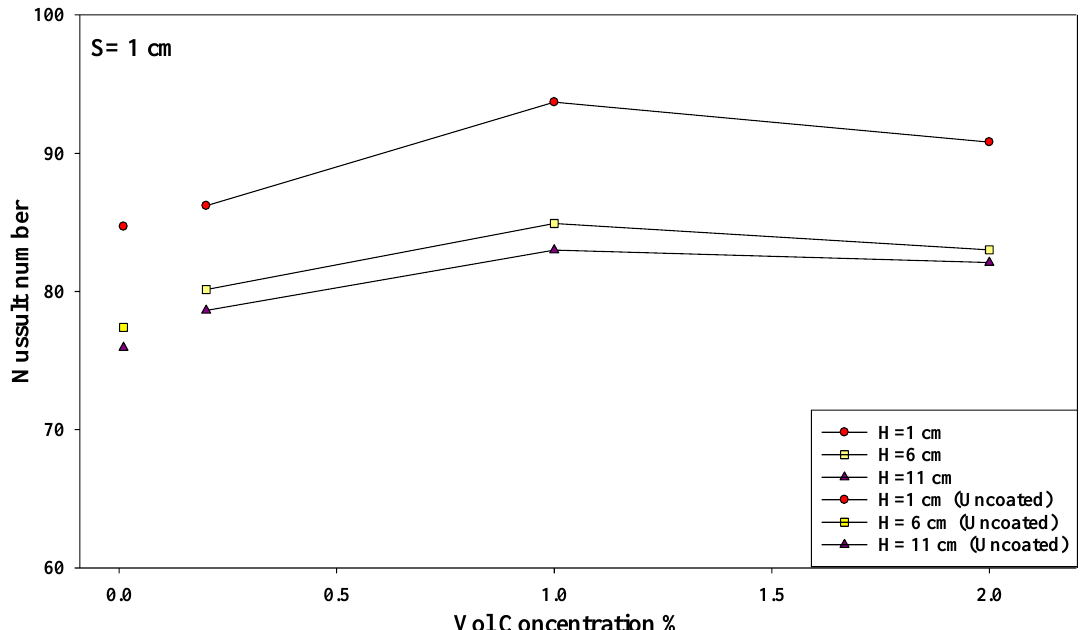
Figure 10. Effect of the nanosolution concentration and nozzle – plate distance when the nozzle – nozzle distance was 1 cm.